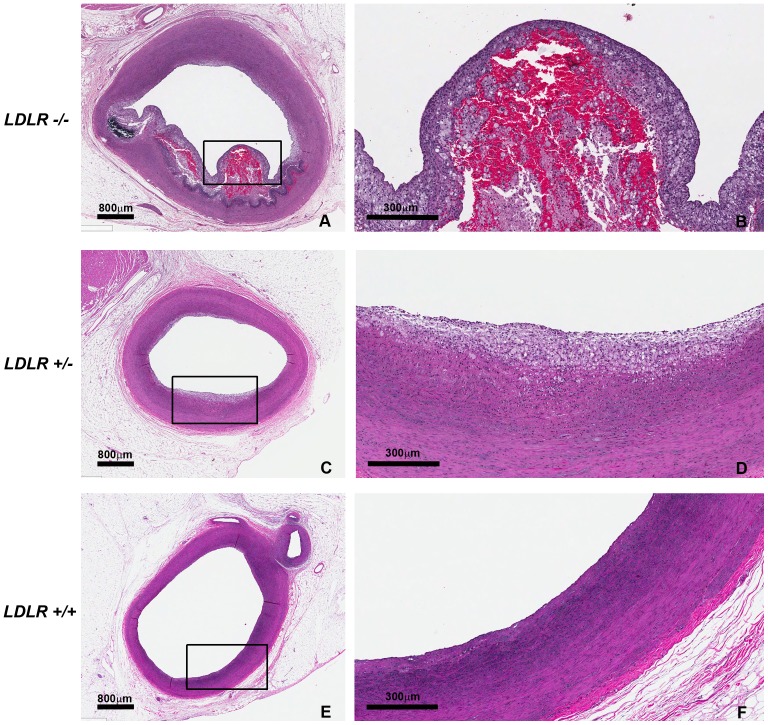
Coronary artery atherosclerosis in 11-month-old LDLR−/−, LDLR +/−, and LDLR +/+ pigs fed a high fat, high cholesterol diet.Representative H&E stained sections from each group are shown: LDLR−/− (A,B), LDLR +/− (C,D), and LDLR +/+ (E,F). Complex lesions were seen in the LDLR−/− pigs (A,B) that exhibited hemorrhage, possible areas of calcification, fibrous caps and foam cells.